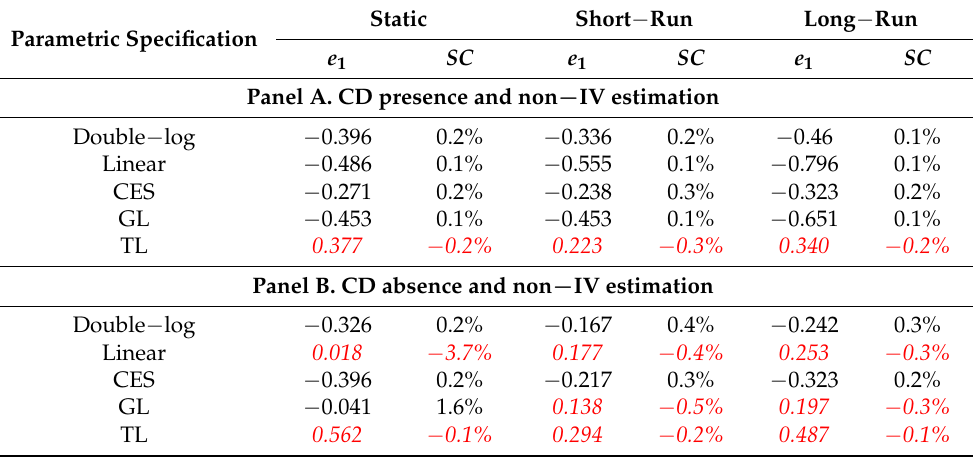
Table 7. Natural gas shortage cost for 2019 for various types of elasticities and specifications.